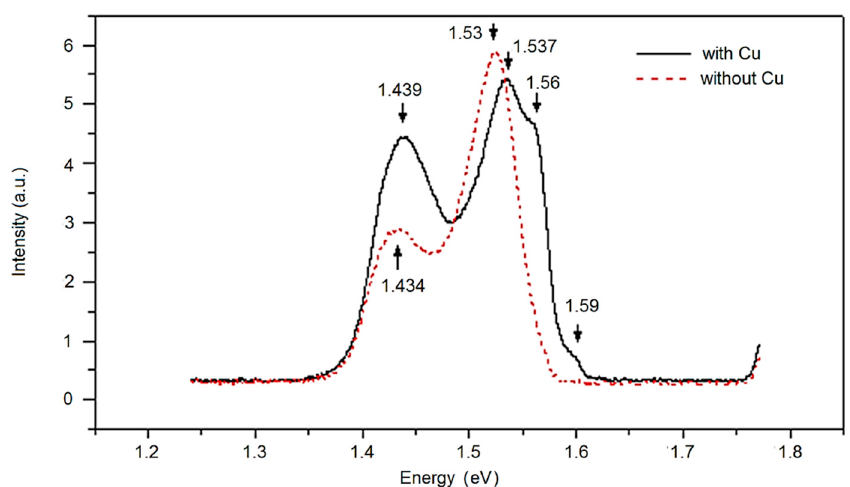
Figure 5. Front side luminescence of Cu-doped (full line) and undoped (dotted line) CdS / CdTe solar cells taken at 10 K.